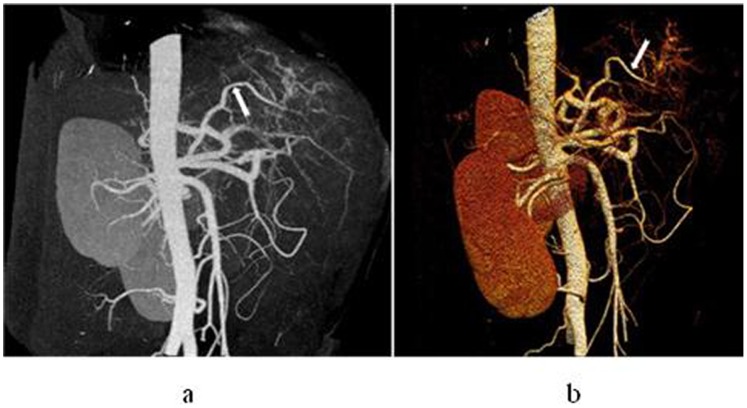
In a 44-year-old man with hepatocellular carcinoma in S2 and S3, left gastric artery participates in blood supply for the carcinoma.Maximum intensity projection (a) and volume rendering technique (b) display that left gastric artery gives off a branch into the lesion and the branch is enlarged apparently (white arrow).